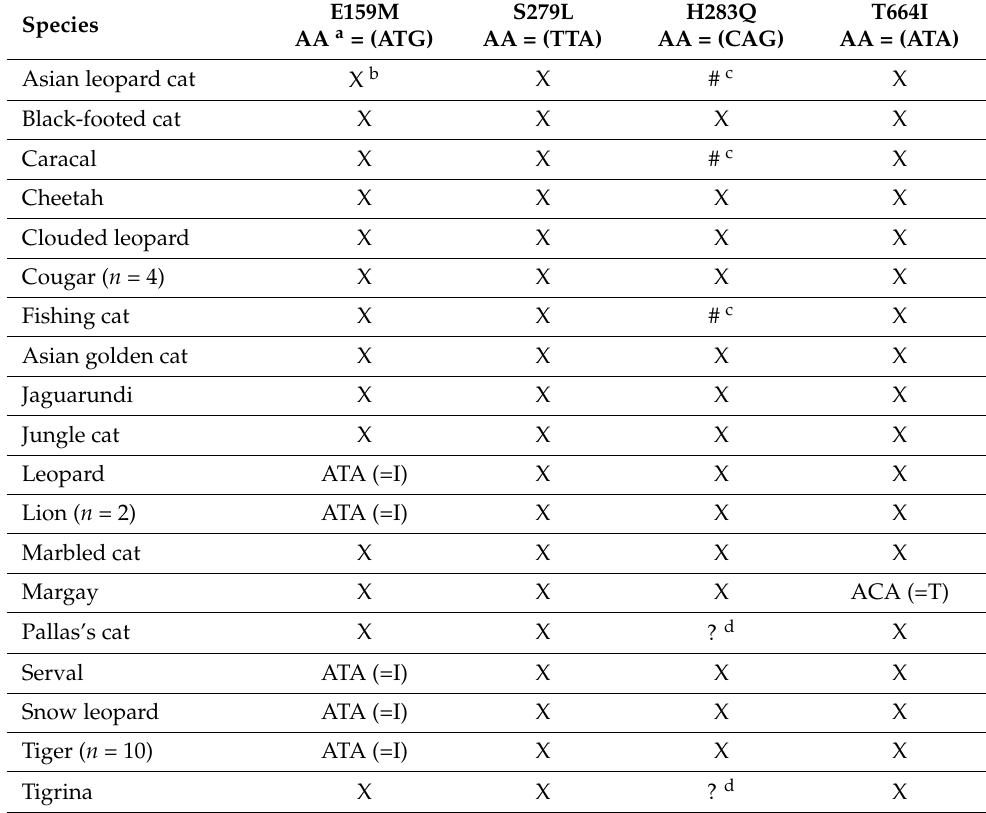
Table 3. Sequencing results for the four domestic cat ABCG2 missense variants in nondomestic felids. One individual per species unless otherwise indicated. E159M Species AA a = (ATG)